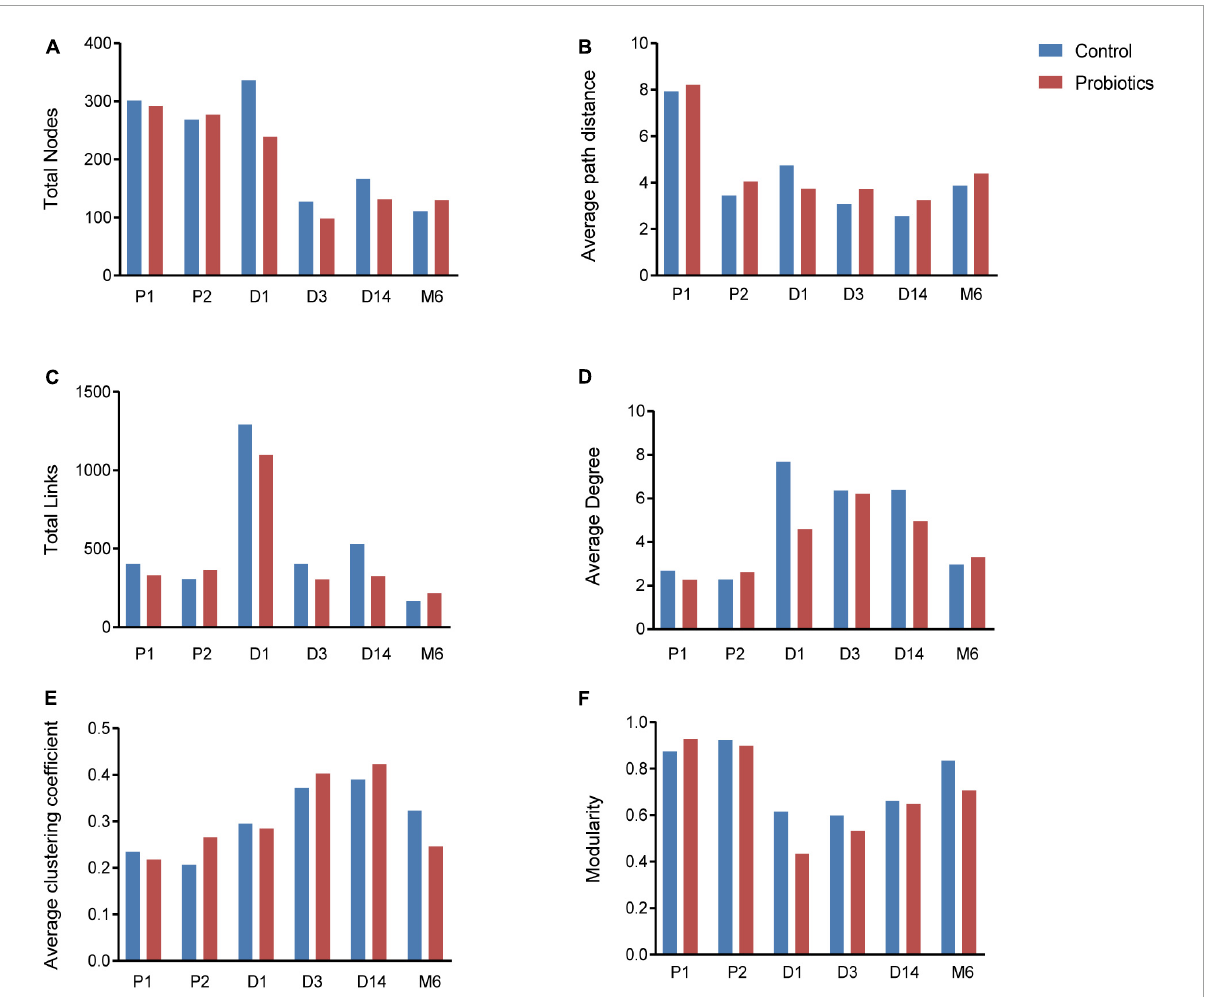
FIGURE3 Topological properties of microbial networks, including total nodes (A) , average path distance (B) , total links (C) , average degree (D) , average clustering coefficient (E) , and modularity (F) . P1 = Fecal samples of pregnant women at the first time collection; P2 = Fecal samples of pregnant women at the second time collection; D1 = Infant fecal samples collected at day 1 after birth; D3 = Infant fecal samples collected at day 3 after birth; D14 = Infant fecal samples collected at day 14 after birth; M6 = Infant fecal samples collected at month 6 after